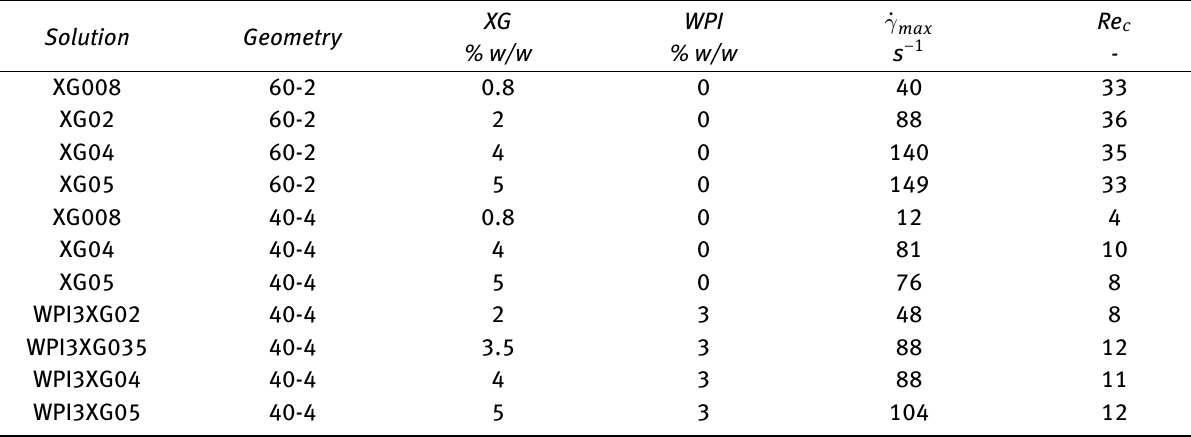
Table 1: Estimated maximum shear rate ˙ 𝛾 max and critical Reynolds number ( Re c ) for all experimental conditions.